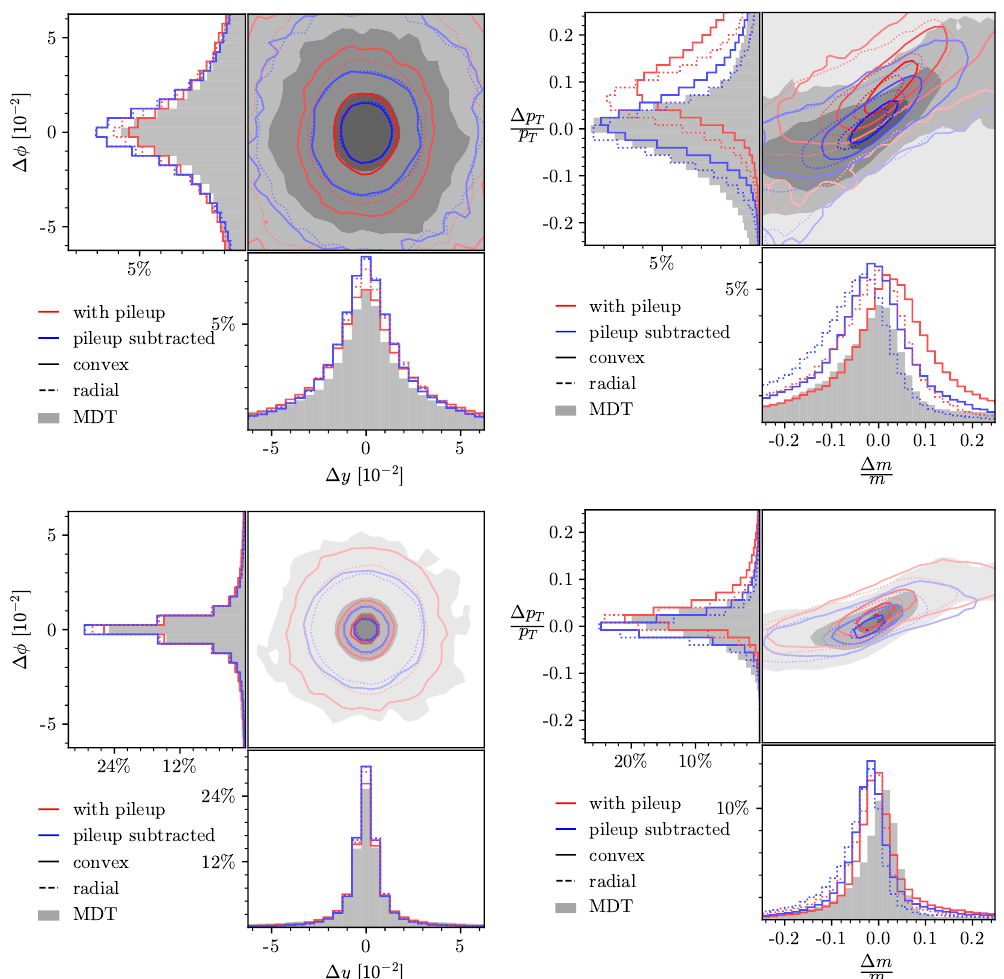
Figure 9. Higgs reconstruction accuracies of the MDT method (gray regions), and CNN method with convex (red solid contours) and radial (red dashed contours) mask. The performances of CNN after pileup subtraction are shown by blue contours. Upper panels: event sample with Higgs trans- verse momentum in the range [200, 250] GeV. Lower panels: event sample with Higgs transverse momentum in the range [400, 450]